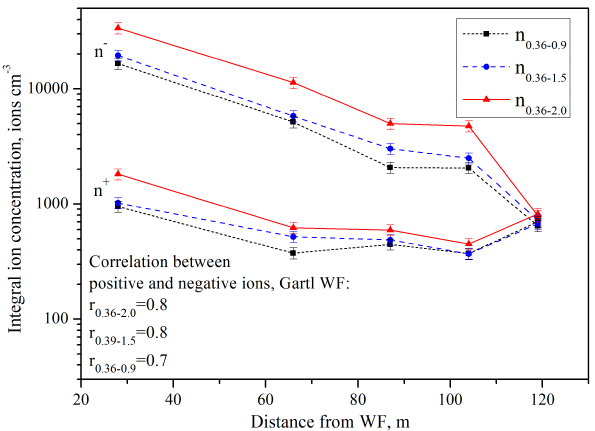
Fig. 12. Negative and positive integral ion concentration ratios ( u ∓ ) versus distance at the Gartl WF.